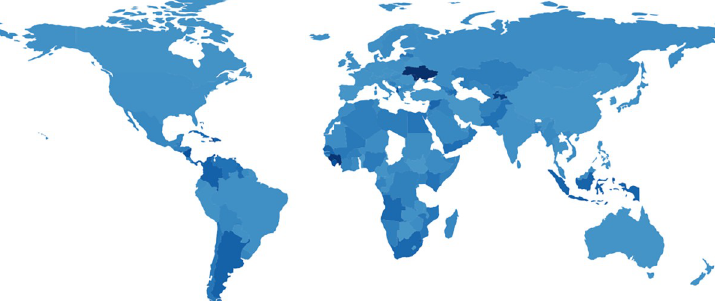
Fig 2. The duration of the initial exponential phase of COVID-19 growth in different countries. Fig 2 shows the duration of the initial exponential phase of COVID-19 growth, as computed by the regime regression illustrated in Fig 1. Fig 2 colors countries darkening linearly from lightest blue (4 days for Sao Tome and Principe, STP) up to darkest blue (256 days for Ukraine, UKR). Python GeoPandas generated Fig 2.